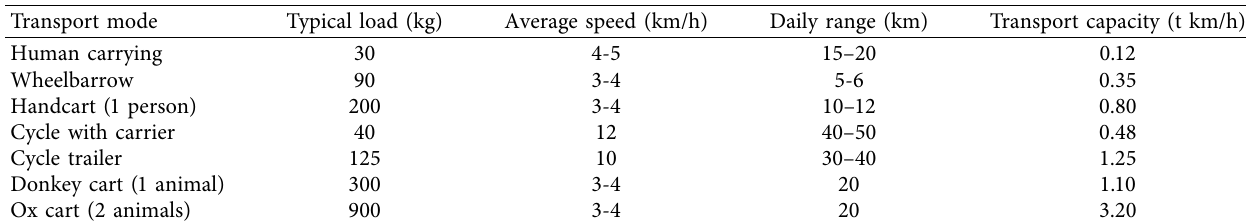
Table 2: Comparison of load carrying capacity and distances for hand-and-foot-operated devices.